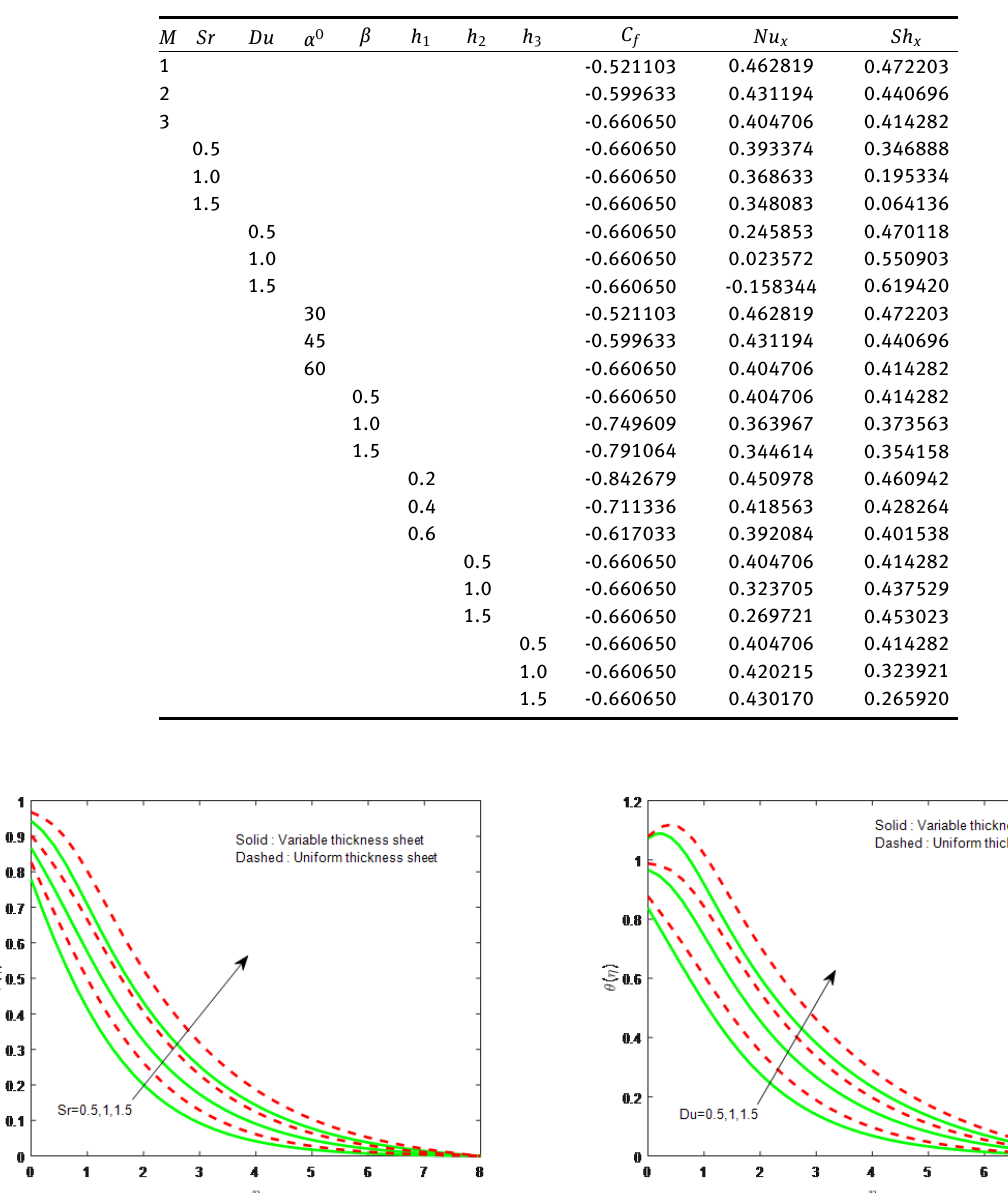
Table 2: Variations in physical quantities for the flow over a uniform thickness sheet